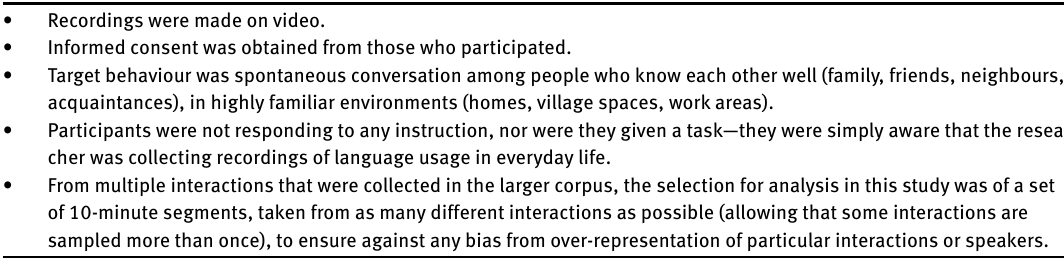
Table 1: Key properties of the data collected for the studies in this